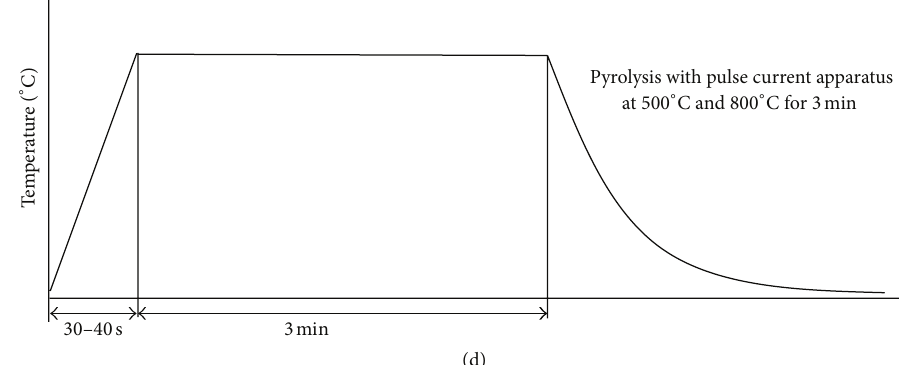
Figure 1: Apparatus and method for collection of pyrolysis products: (a) graphite dies and quartz tube with sample, (b) pyrolysis oil in collection bottle, (c) gas sampling bag (aluminum bag (2L)), and (d) Heating pattern used for pyrolysis using pulse current